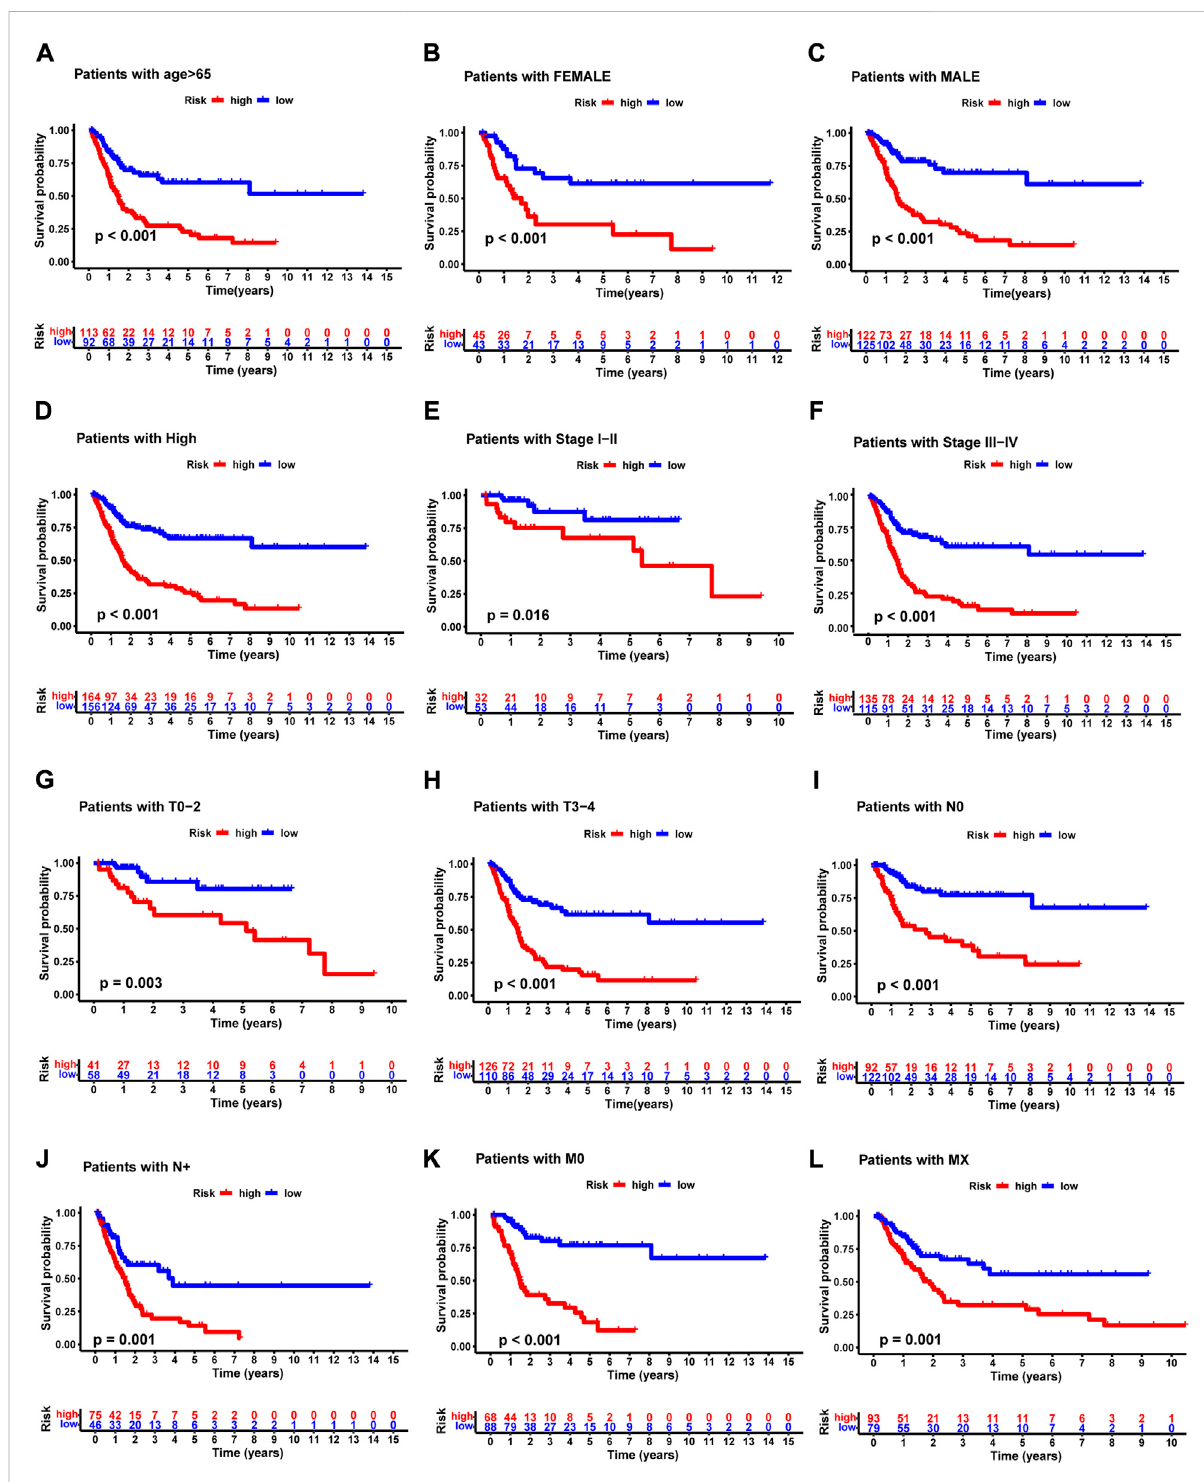
FIGURE 7 Kaplan – Meier survival curves of high- and low-risk groups among patients sorted according to different clinicopathological features. (A) Age. (B,C) Gender. (D) Pathological grade. (E,F) Pathological stage. (G,H) T-stage. (I,J) N-stage. (K,L) M-stage. T, tumor; N, lymph